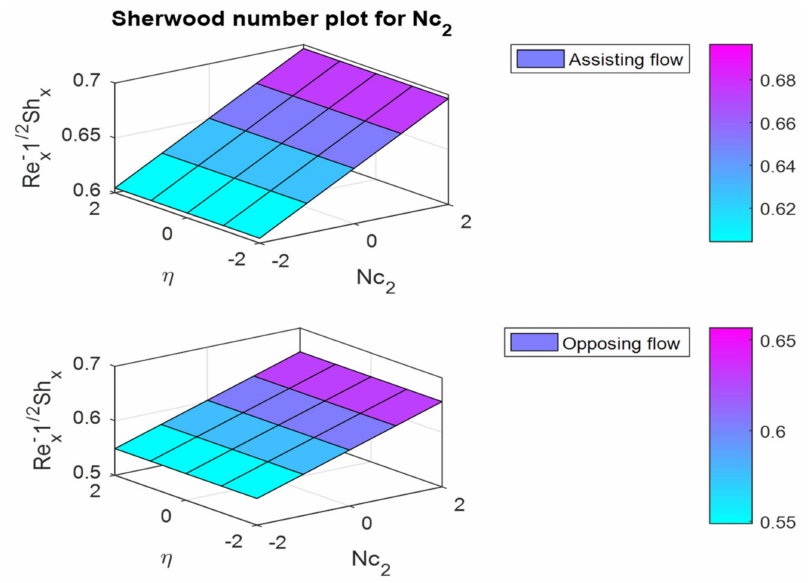
Figure 36. Surface plots for the φ (cid:48) ( 0 ) for dissimilar values of Nc 2 . Figures 37–40 illustrate the shear stress, Nusselt number, and salt_1 and salt_2 Sher- wood number plots for different values of Lewis number Le 1 . Figure 37 shows that for increasing values of Le 1 , the skin friction coefficient increases at 0.045962 (assisting flow) and 0.048975 ( λ < 0 ) rates. The θ (cid:48) ( 0 ) is decreased at the rates of − 0.00653 and − 0.00881 in the fluid flow cases. The salt_1 Sherwood number for the Lewis number is increased in assisting and opposing flow cases, whereas the reverse trend can be observed for salt_2 Sherwood in both cases.